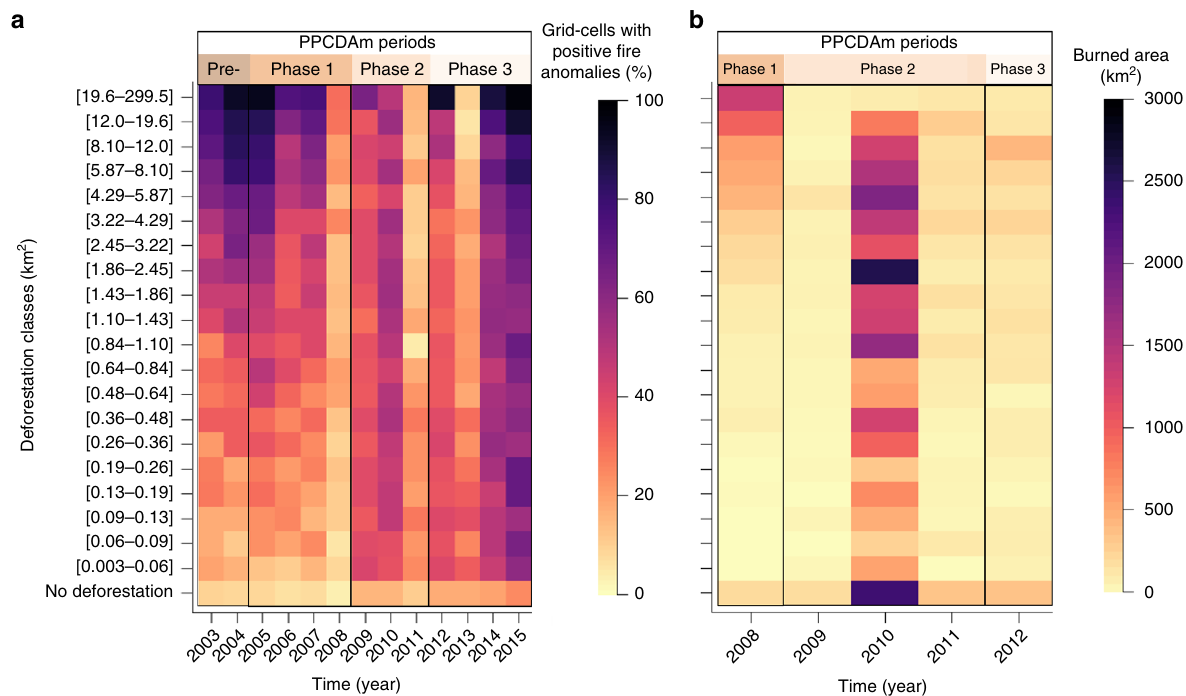
Fig. 7 Temporal quanti fi cation of active fi re anomalies and burned area across the deforestation gradient. Temporal patterns of positive active fi re anomalies (number of grid cells with positive anomalies) ( a ) and forest plus secondary forest burned area (total area burned) ( b ) across the deforestation gradient. Deforestation categories correspond to the area deforested each year. The fi gure shows deforestation data classi fi ed in 20 percentiles, in addition to one class where deforestation was not observed (no